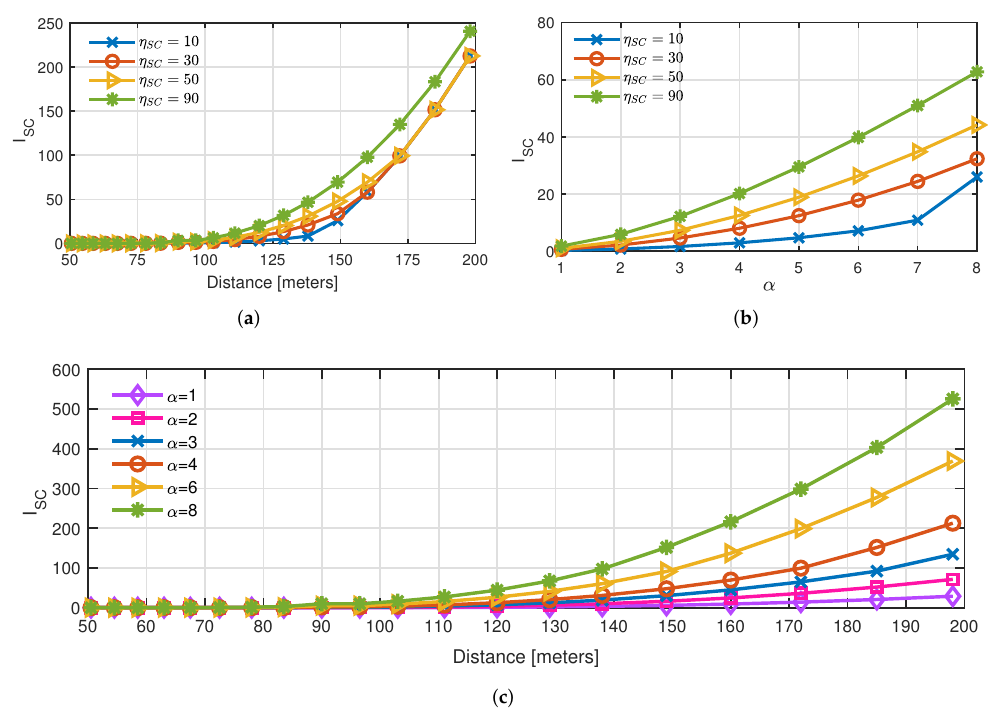
Figure 6. SNR improvement of SC users for various D , α , and η SC . ( a ) For α = 4 ( b ) For D = 120 m ( c ) For η SC =